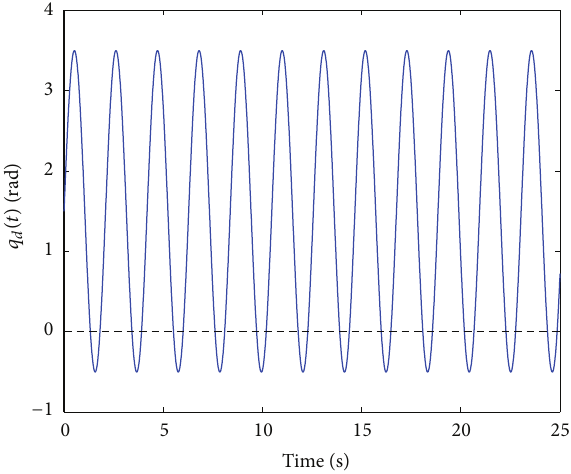
Figure 10: Desired joint trajectory 𝑞 𝑑 (𝑡) the real-time evaluations. Notice that with trajectory the effect of the gravitational force is maximized. Figure 10 shows the time history of the desired joint trajectory 𝑞 𝑑 (𝑡) in (71).